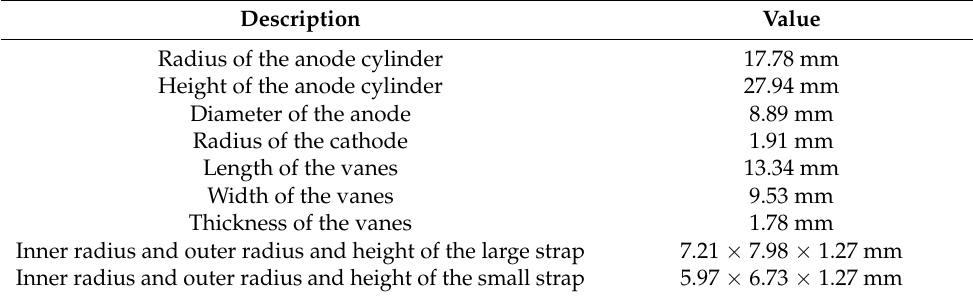
( b ) Figure 2. π− mode electric field distributions. ( a ) Vector field chart. ( b ) Abs field chart.